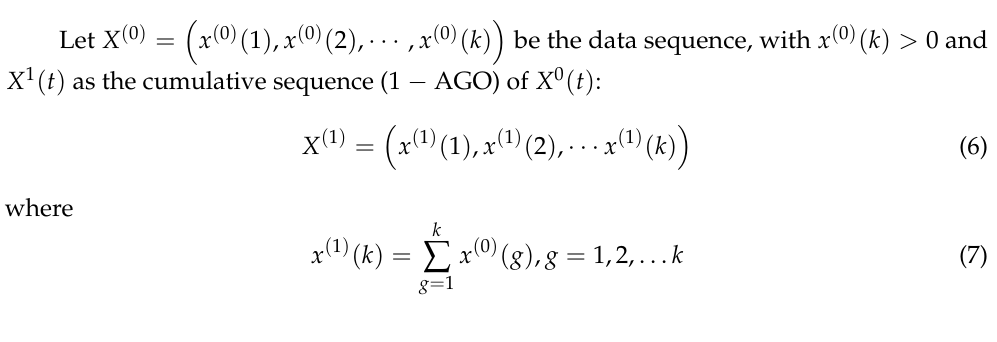
Figure 2. Grey Verhulst Model based on metabolic